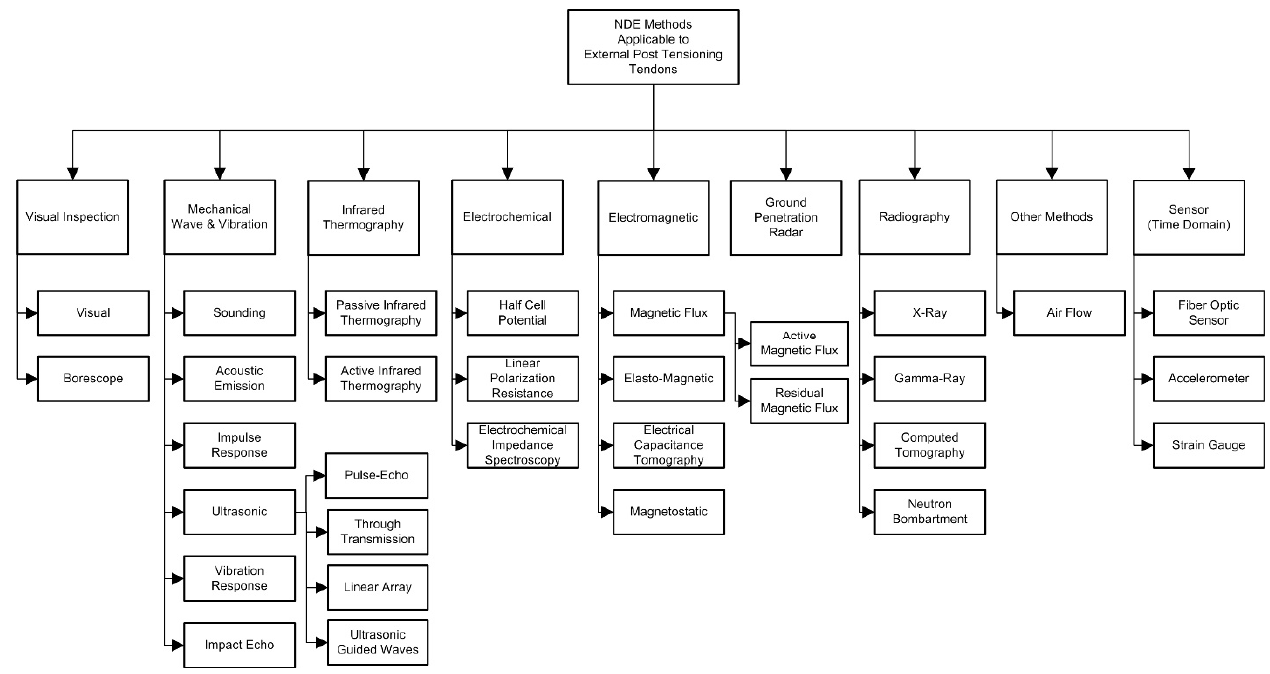
Figure 3. Classification of NDE methods applicable to external post-tensioning system.